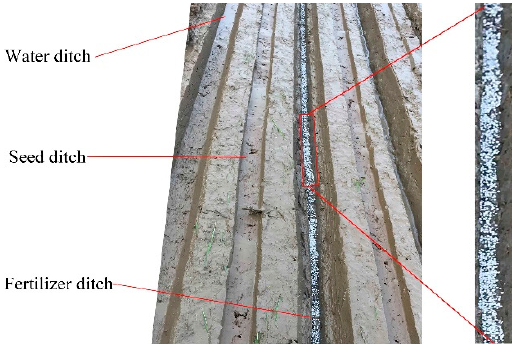
Figure 9. Presentation of paddy field after fertilization. Table 9. Results of field tests.